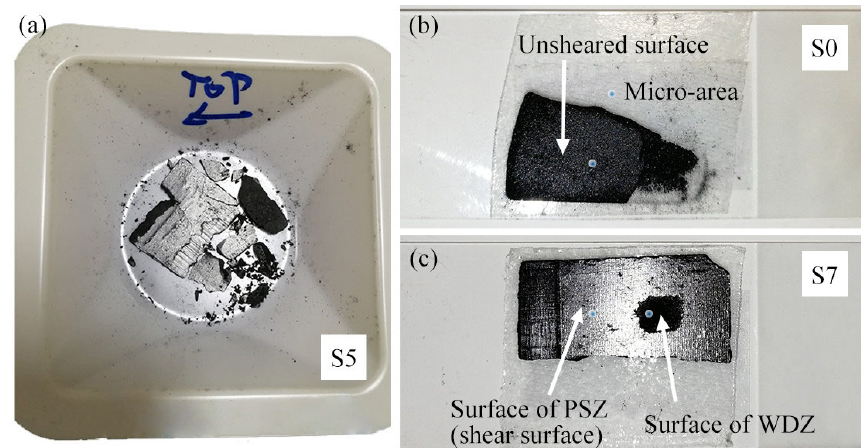
Figure 1. Post-treatment of the recovered fragments used for microstructural observation, XRD and Raman spectroscopy. (a) Stored loose fragments. (b) The free surface of the unsheared sample S0 that was glued on a glass slide. (c) The slip surface of sample S7, showing the surface of the principal slip zone (PSZ) and weakly deformed zone